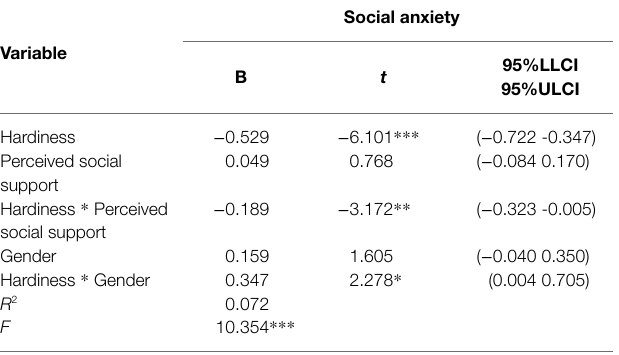
TABLE 7 | Testing the moderating roles of perceived social support and gender.